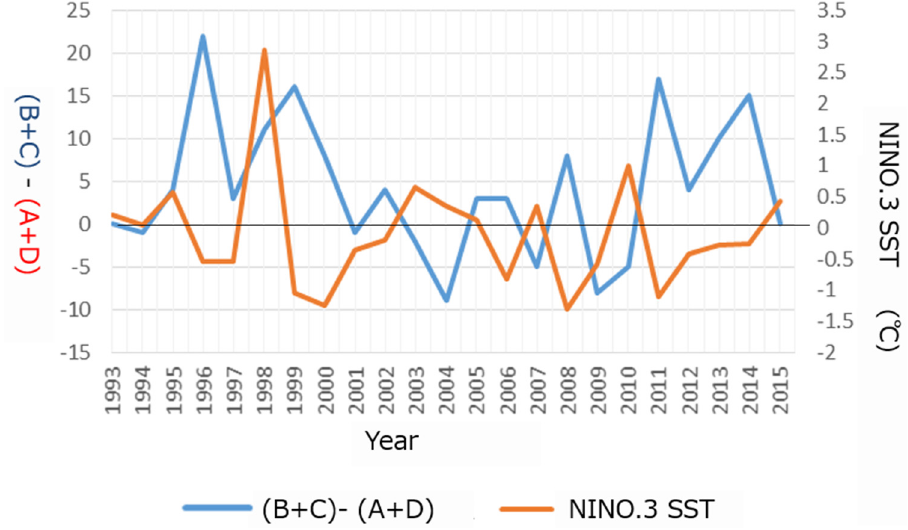
Figure 12. Relationship between the number of pattern appearance difference (B + C) − (A + D), and Nino.3 SST. Numbers on the x − axis indicate year (e.g., 98 means the 1997/1998 winter).